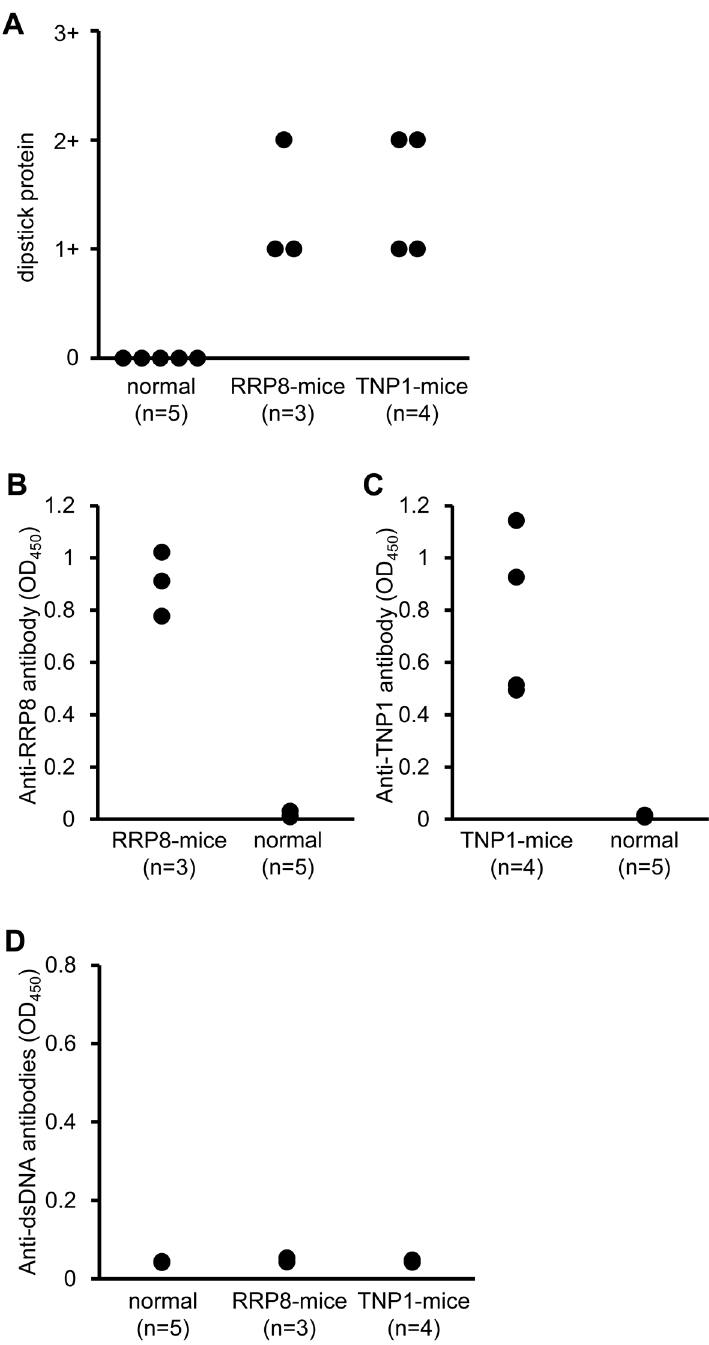
Fig 6. Measurement of proteinuria (A) and anti-RRP8 (B), anti-TNP1 (C) or anti-dsDNA (D) antibodies in murine serum samples. Proteinuria was assessed before sacrifice. The urine diluted 1:10 was examined and graded with a score of 0 ( < 30mg/dL); 1 (30-99mg/dL); 2 (100-299mg/dL); or 3 (300-999mg/dL). Serum samples were assayed by ELISA using purified human RRP8 or TNP1 protein. RRP8- or TNP1-mice; C57BL/ 6 mice injected repeatedly with RRP8 or TNP1, respectively. normal; normal C57BL/6